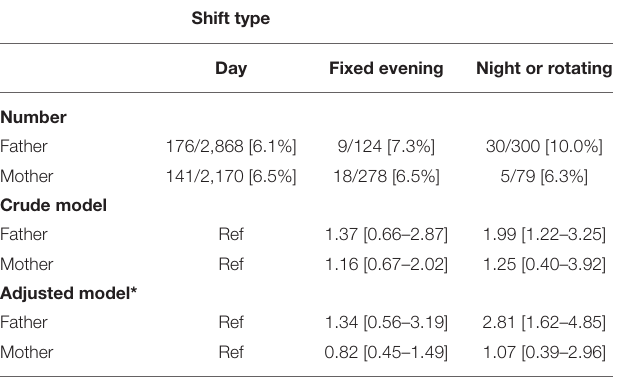
TABLE 6 | Logistic regression analysis for dyslipidemia (low-density lipoprotein cholesterol ≥ 130 mg/dl) in the participant children by working shift types of the father or